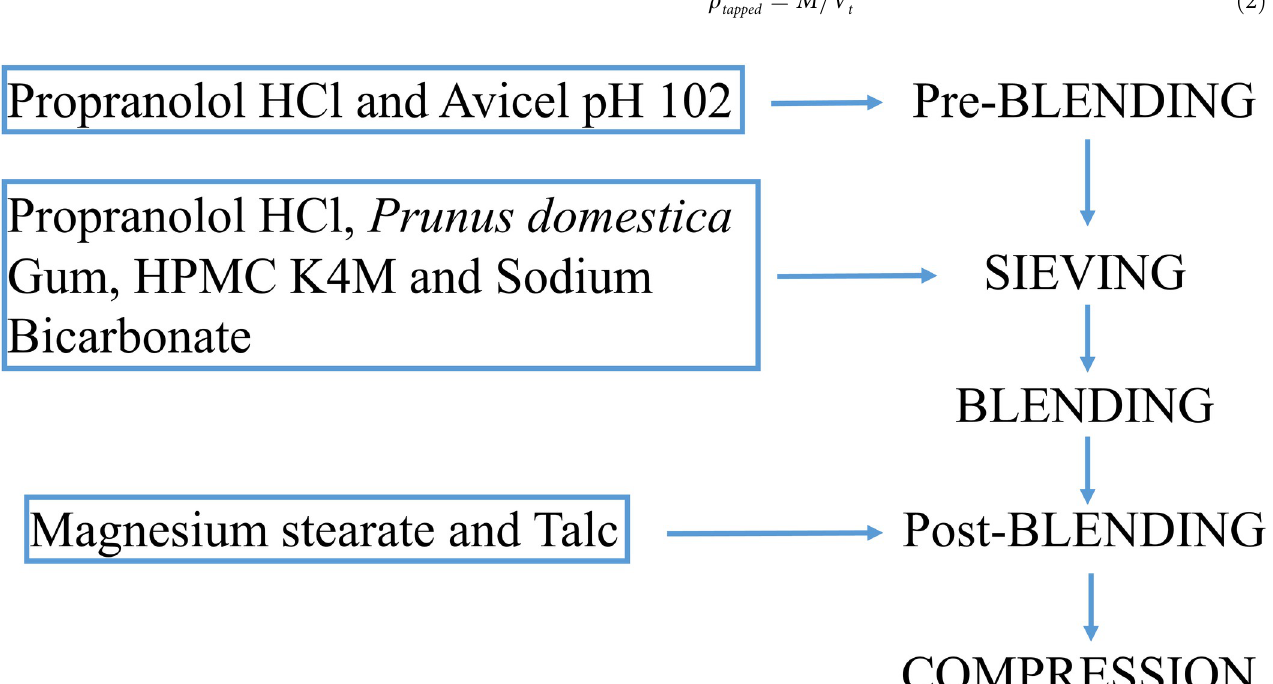
Fig 1. Schematic representation of direct compression of propranolol HCl floating tablets.